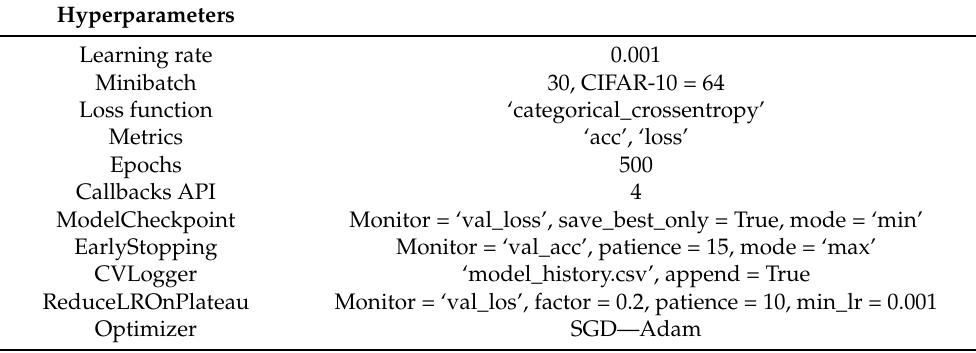
Table 1. Training parameters of the proposed